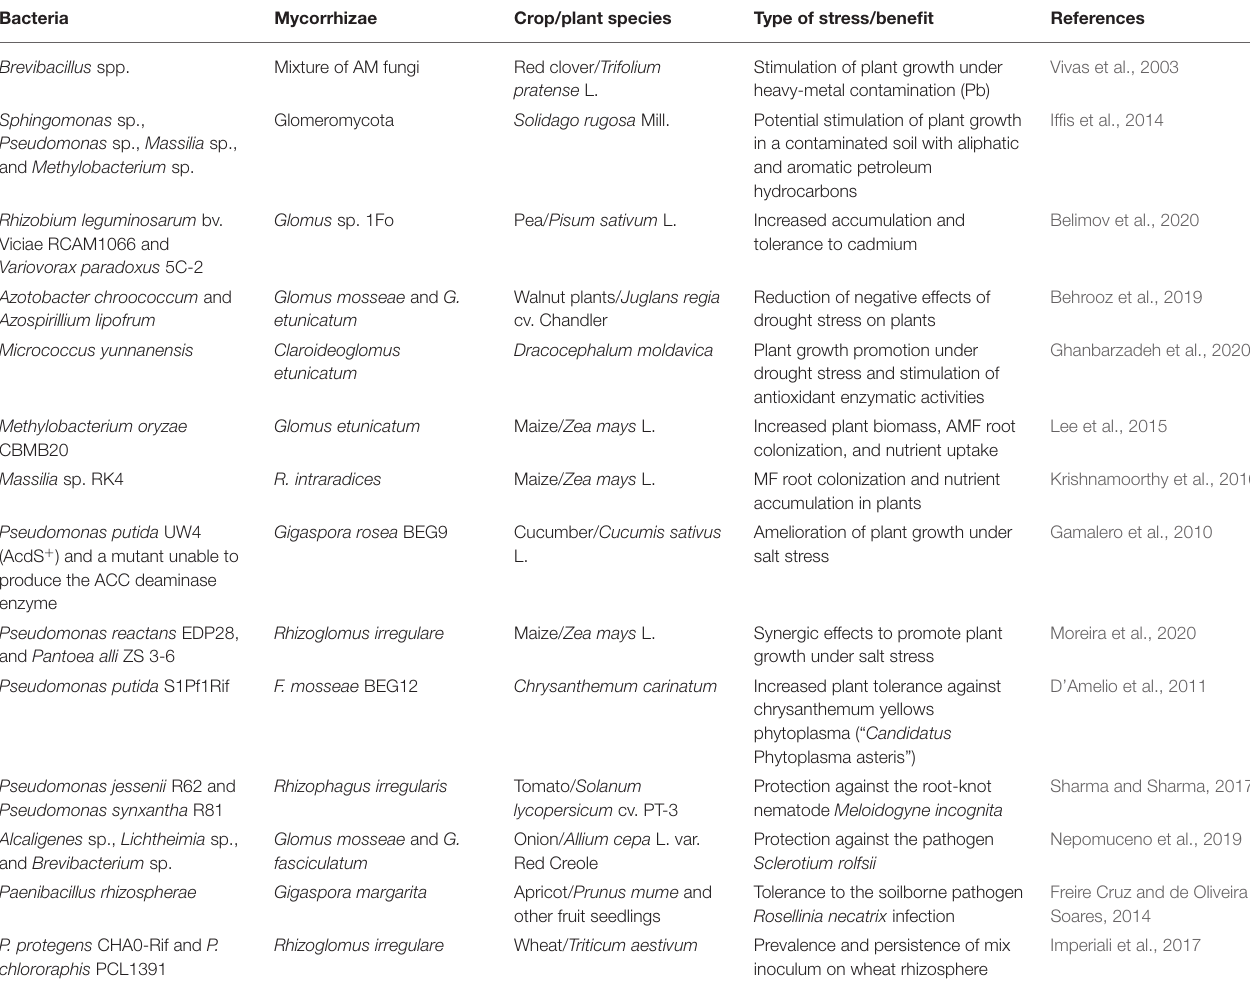
TABLE 2 | Example of works reporting the beneficial interaction between Mycorrhizae and plant growth-promoting bacteria under abiotic and biotic stress